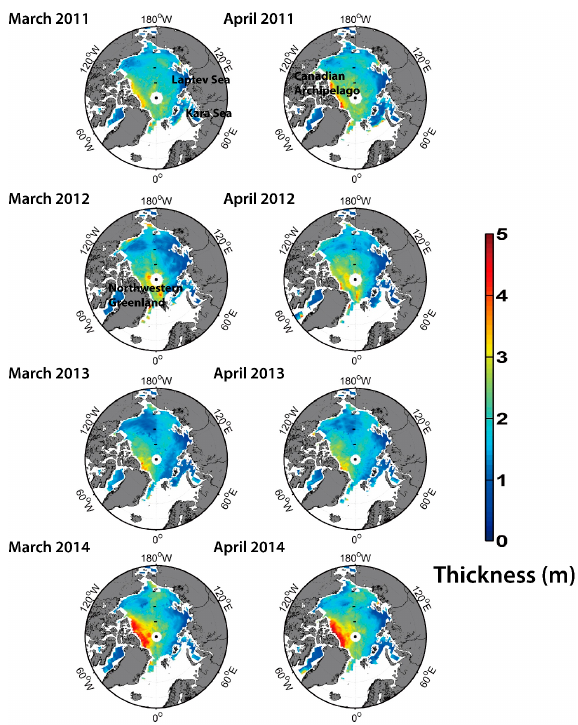
Figure 10. Arctic sea ice thickness from CryoSat-2 for March and April between 2011 and 2014 based on the IC scheme. Non-sea ice areas were masked out using the EUMETSAT Ocean & Sea Ice Satellite Application Facility (OSI SAF) sea ice type data.